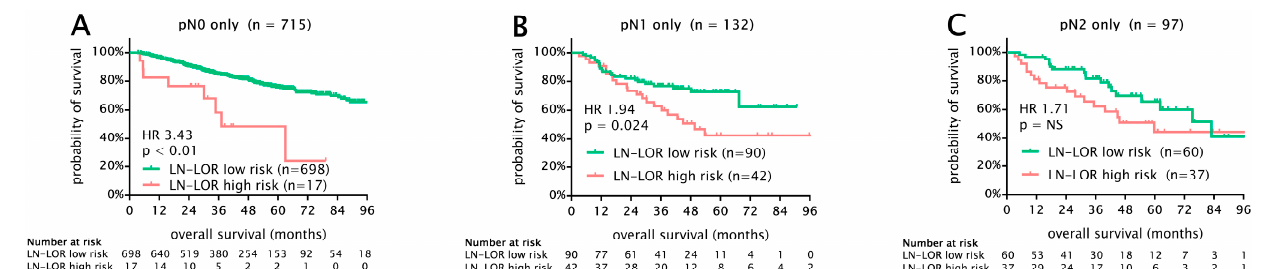
Figure 2. Kaplan–Meier survival analysis for OS in 944 patients with stage I-III NSCLC undergoing